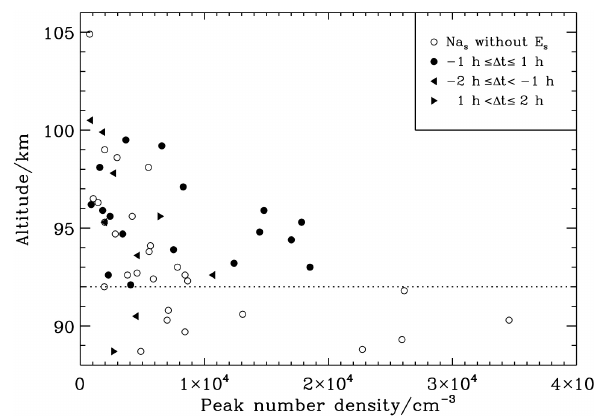
Figure 5. Altitude and peak number density of all Na s layers. 1t represents the difference of occurrence time for Na s and E s lay- ers. Positive value of 1t means that a Na s layer occurs before an E s layer. While a negative value of 1t means that a Na s layer lags behind an E s